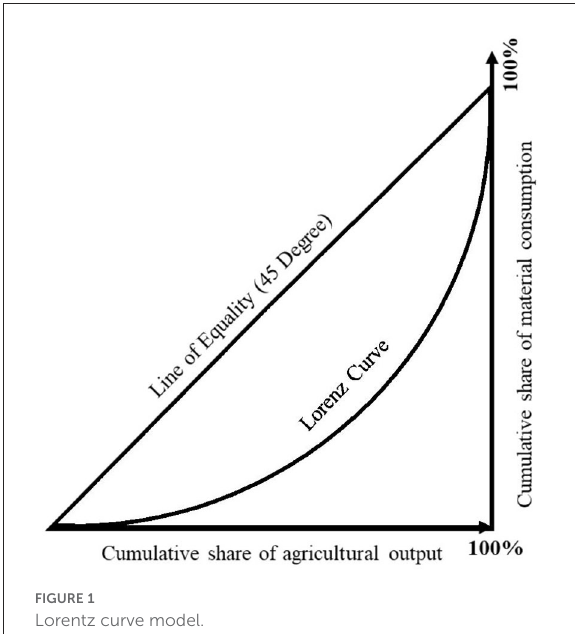
FIGURE1 Lorentz curve